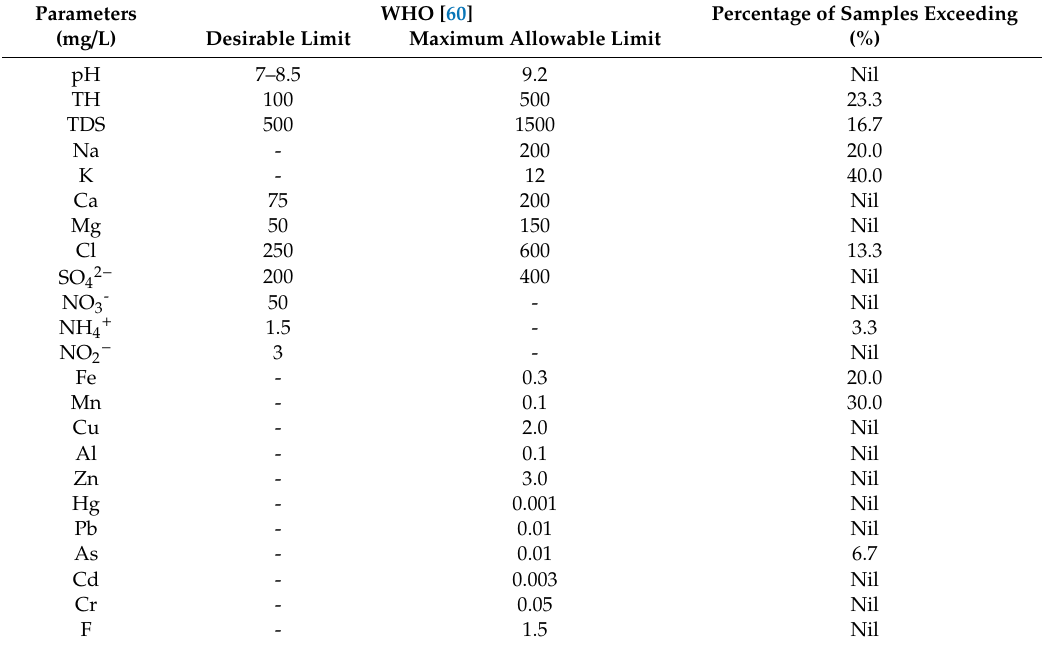
Table 3. Groundwater samples of the study area exceeding the allowable limits prescribed by WHO for drinking